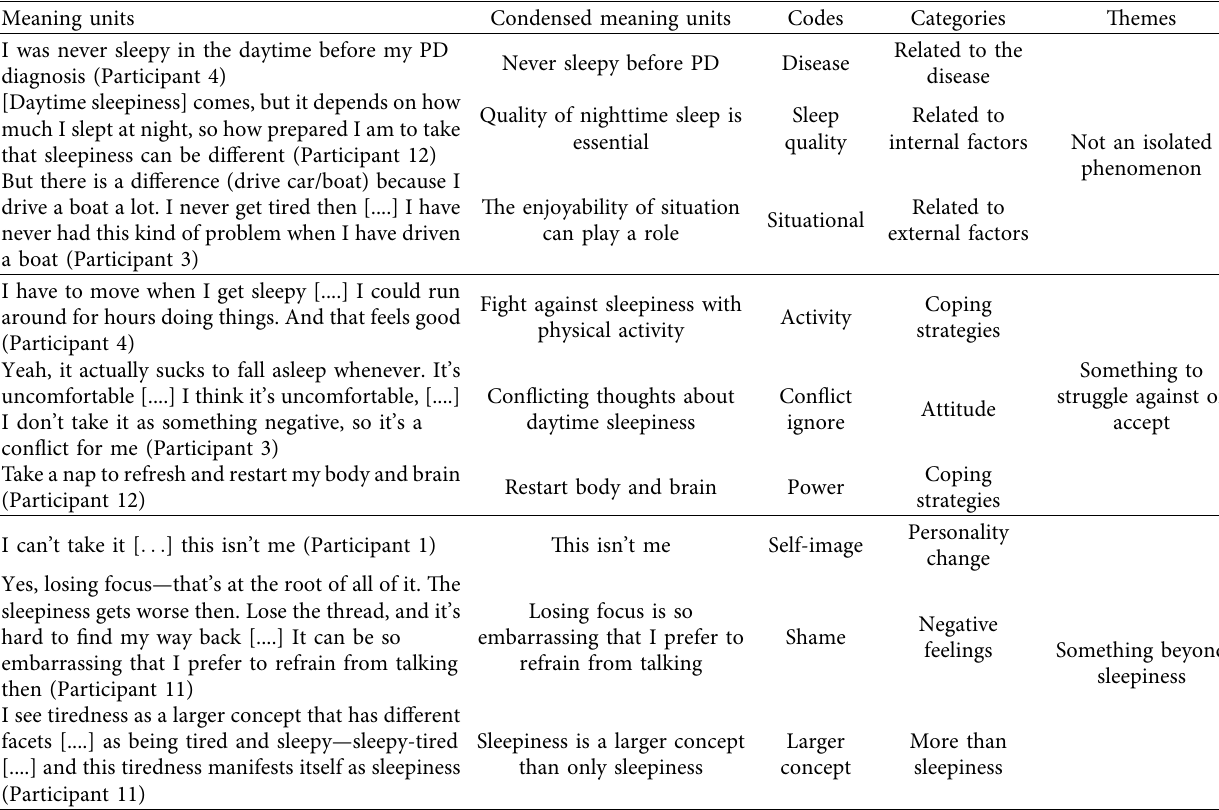
Table 2: An overview of the analytical process, including examples of meaning units, codes, categories, and themes. Meaning